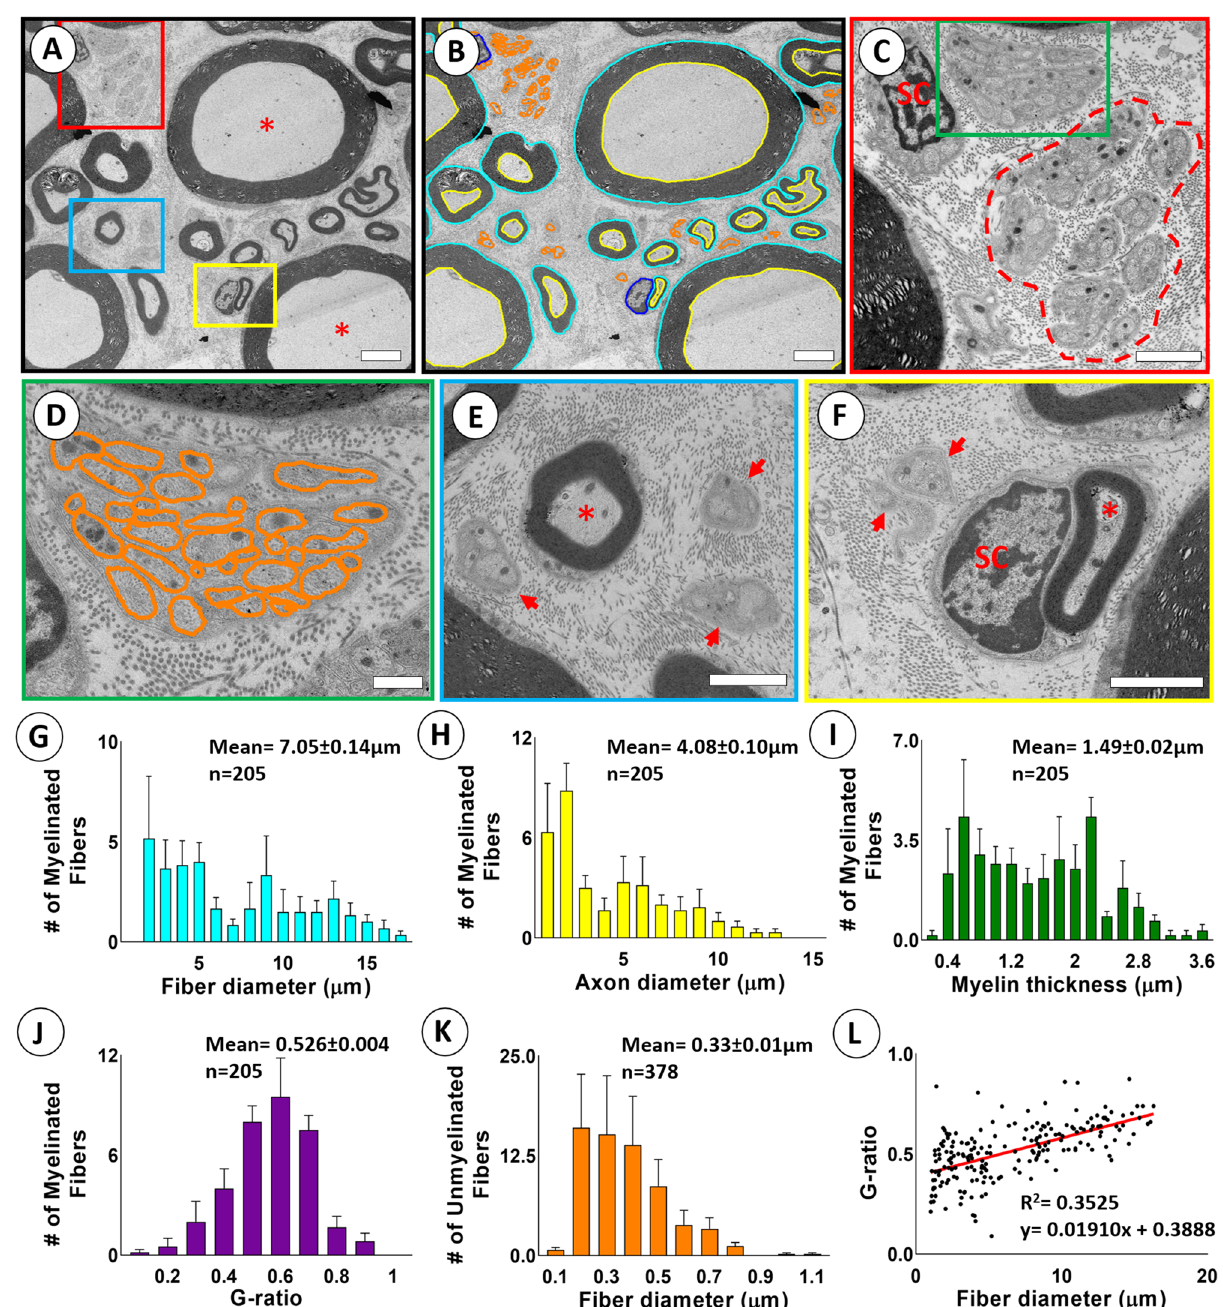
Figure 4. Determination of size and myelination of primate ventral roots using SAE correction in TEM. ( A ) Representative electron micrograph from an S2 VR demonstrating myelinated fibers of varying sizes and myelination and unmyelinated axons. *Indicates large myelinated axon. ( B ) Segmented electron micrograph with outer and inner contours of myelinated fibers in blue and yellow, respectively. Contours of unmyelinated fibers are in orange. ( C ) Detail of boxed are in ( A ) showing cluster of unmyelinated fibers. ( D ) Remak bundles of unmyelinated fibers in green box in ( C ) with surrounding collagen fibers. ( E ) Detail of blue box in A. with small myelinated fiber and adjacent unmyelinated fibers. ( F ) Detail of small myelinated fiber indicated by * and Schwann cell nucleus (SC) in yellow box in ( A ). ( G–K ) Frequency distribution graphs of fiber diameter, axon diameter, myelin thickness, and G-ratio for 205 myelinated fibers and fiber diameter for 378 unmyelinated fibers from representative region of interests (ROIs) in S2 VRs of rhesus macaques (n = 6). ( L ) Graph depicting correlation between fiber diameter and G-ratio of 205 myelinated fibers pooled from representative ROIs in S2 VRs of rhesus macaques (n = 6). Scales: 4 µm in ( A,B ); 2 µm in ( C ); 600 nm in ( D ); 2 µm in ( E ); 2 µm in ( F